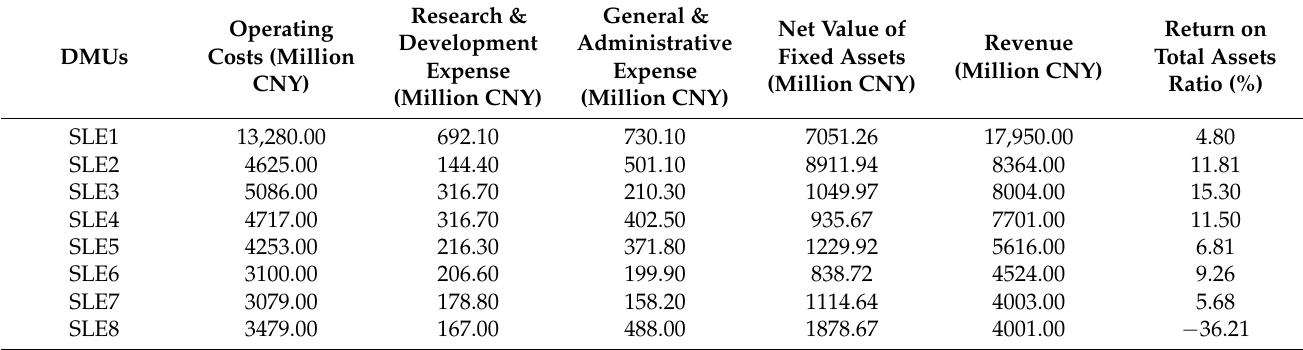
Table A2. Input and output variables for 34 listed LED energy enterprises in